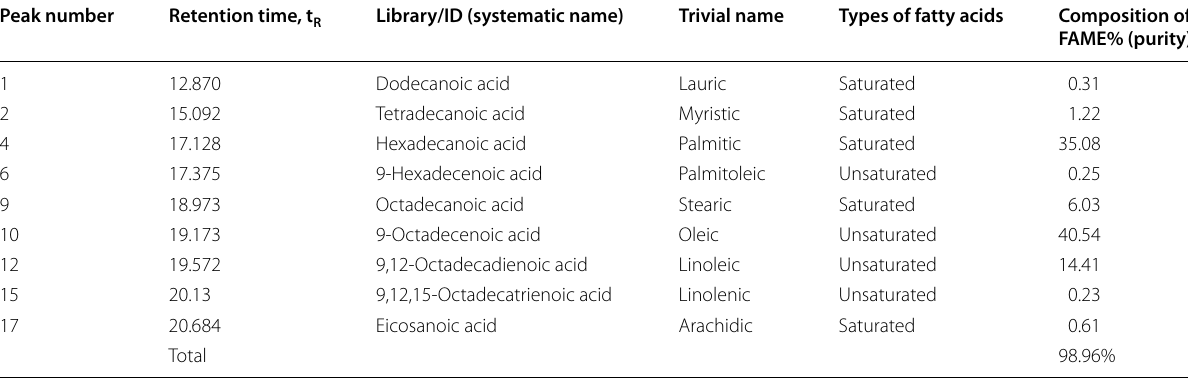
Table 1 GC–MS results for crude biodiesel separated from glycerol after gravitational settling Peak number